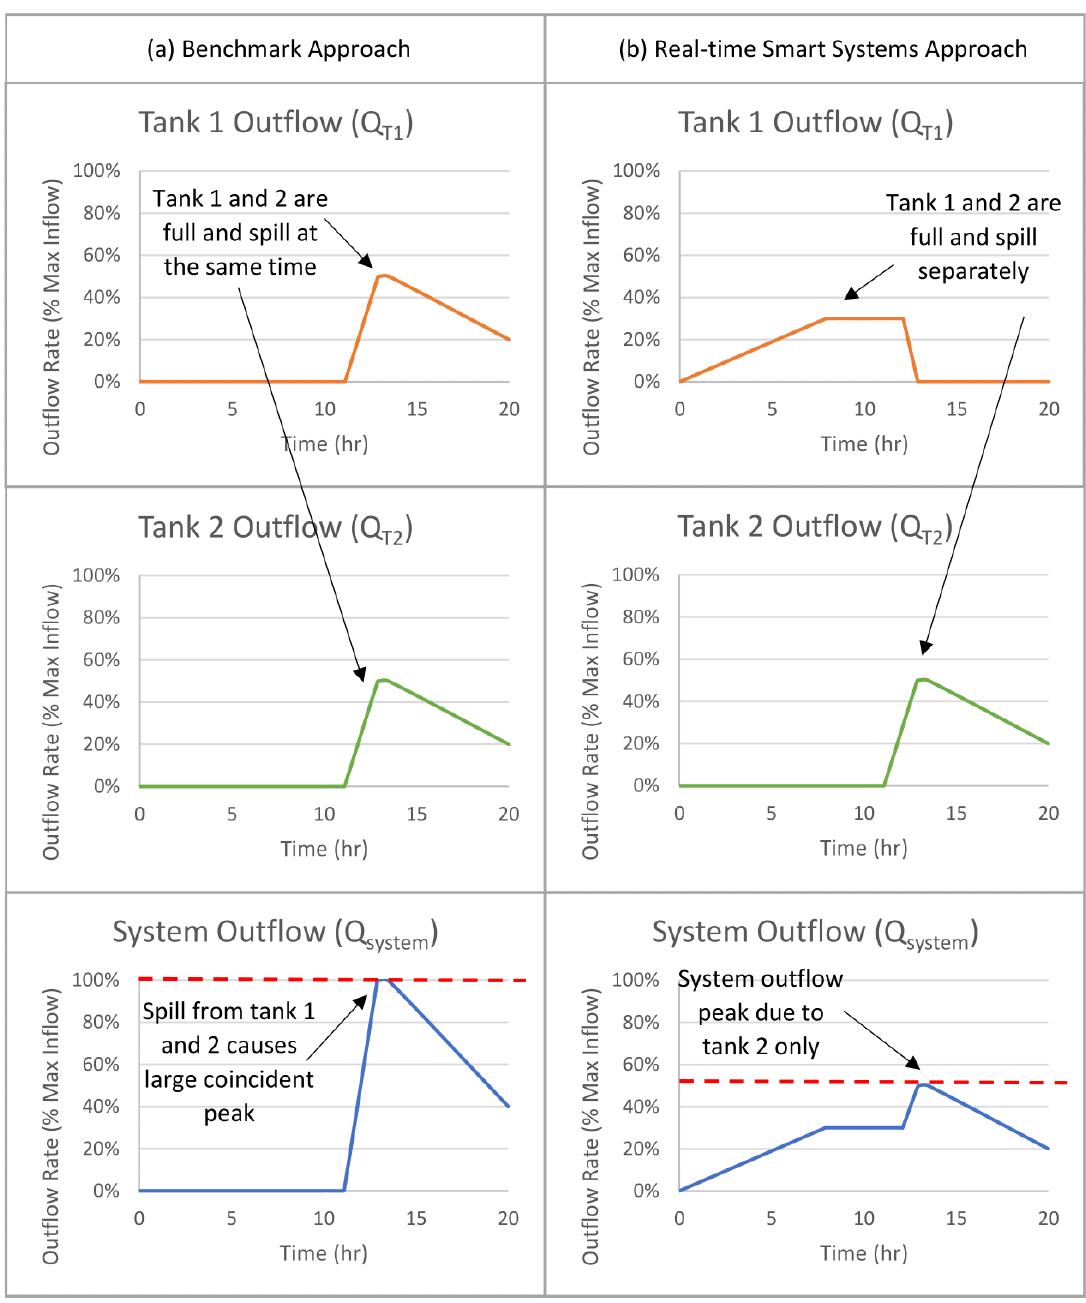
Figure 2. Conceptual illustration of performances of ( a ) “benchmark approach” (i.e., tanks emptied prior to the arrival of the storm, but not controlled during the storm) and ( b ) “real-time smart systems approach” (i.e., tanks emptied prior to the arrival of the storm, and controlled as a system during the storm so as to minimize peak system outflow).